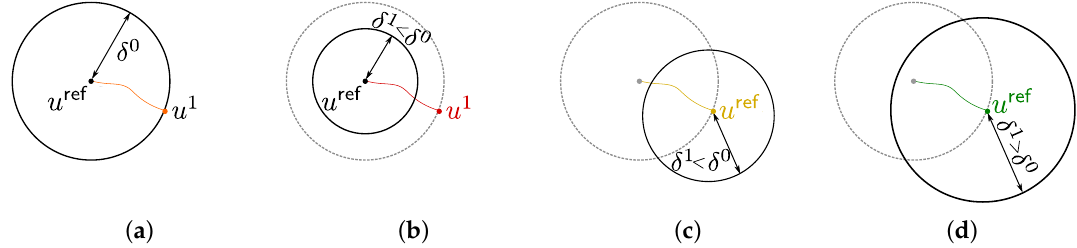
Figure 5. Trust region method. ( a ) The Reduced Order Model (ROM)-based optimal control problem is solved within the trust region δ 0 . ( b ) If the improvement is poor for the full system (i.e., ρ is small), then the trust region radius is reduced, and we repeat the computation with the same problem. ( c ) If the improvement is acceptable (intermediate values of ρ ), then we compute a new model and proceed with a smaller trust region δ 1 < δ 0 . ( d ) If the improvement is good (i.e., ρ ≈ 1), then the trust region radius is